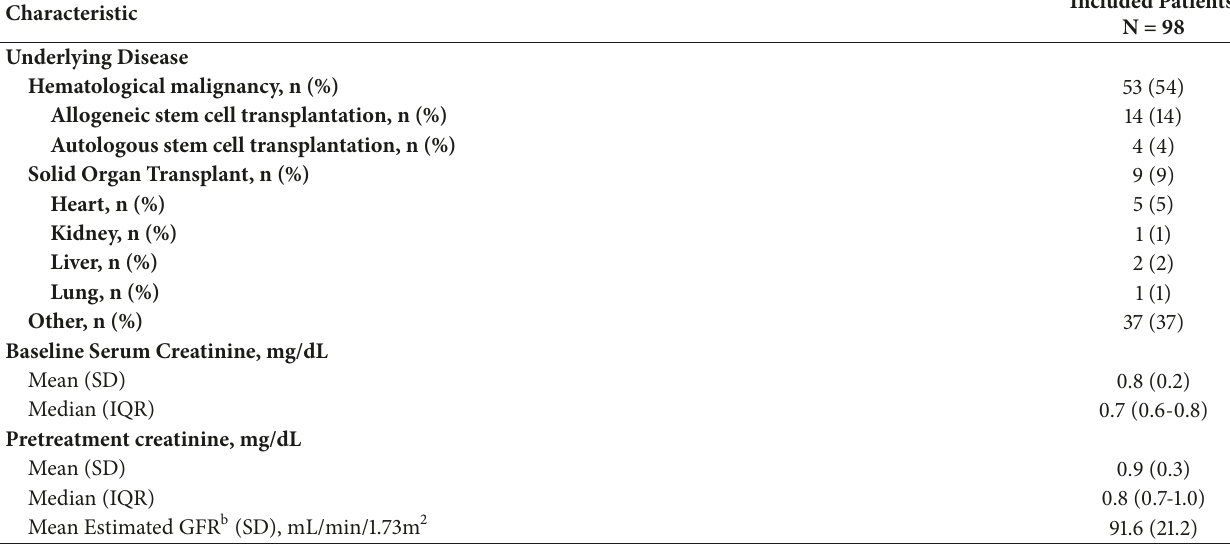
Table 1: Baseline characteristics.